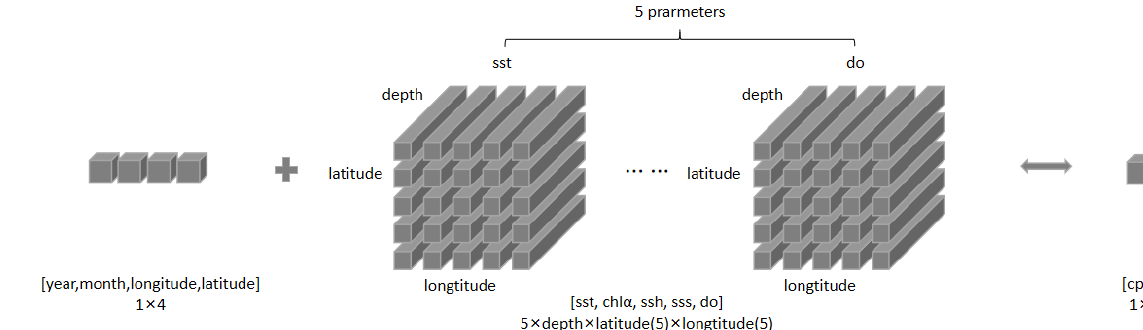
Figure 5. Env_Fishery data structure.